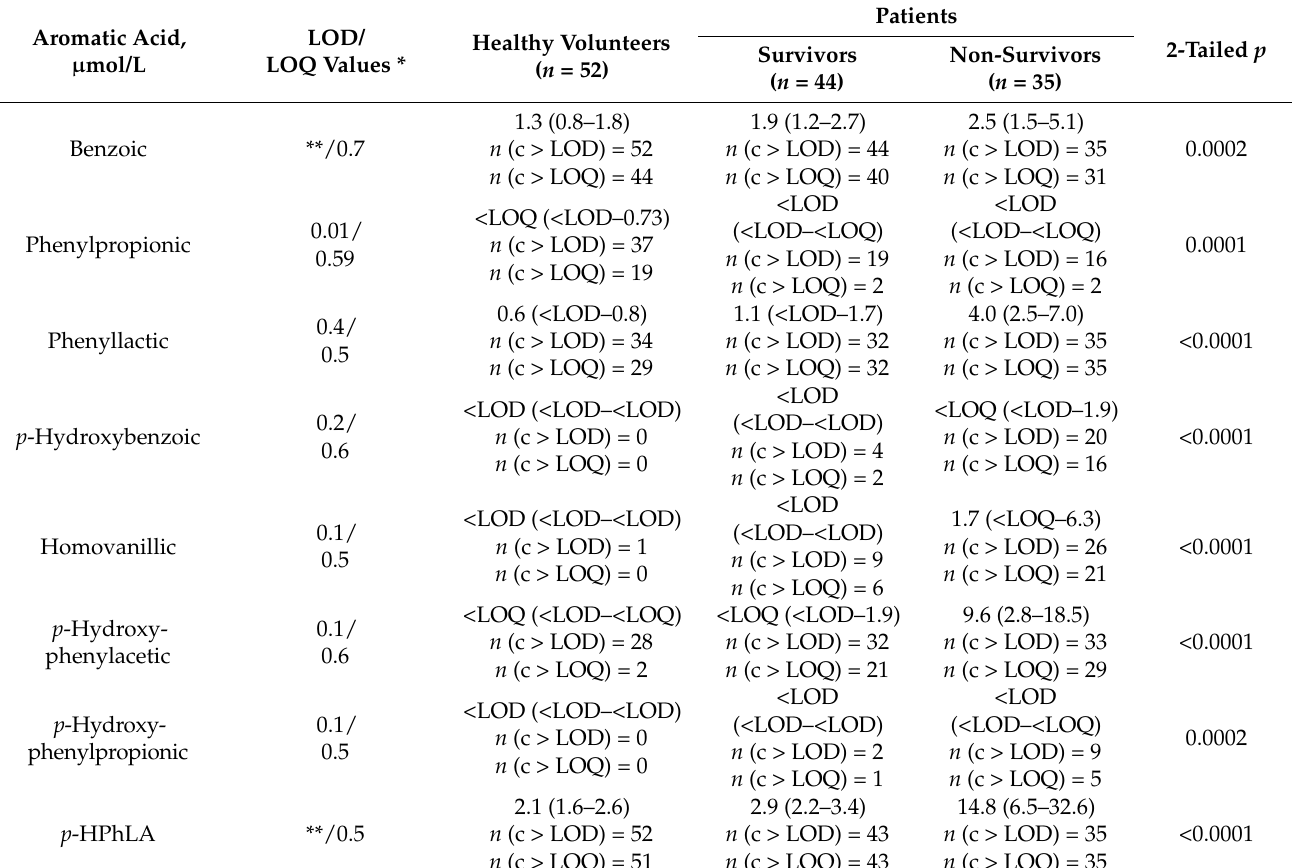
Table 3. Results of the GC-MS analysis of serum samples from healthy volunteers ( n = 52) and critically ill patients ( n = 79) taken on the day of admission to the intensive care unit. Data are presented as median and interquartile range (25–75%). The results for the Kruskal–Wallis test for the independent groups of healthy volunteers, survivors, and non-survivors, which are significant at p < 0.05, are demonstrated. The Holm–Bonferroni method was used to adjust p -values for multiple comparisons. For each parameter n (c > LOQ) indicates the number of samples in which this parameter has been quantitatively measured. To perform the statistical test missing values (i.e., below the limit of detection) were replaced by the half of the minimum of non-missing values. Patients 2-Tailed p